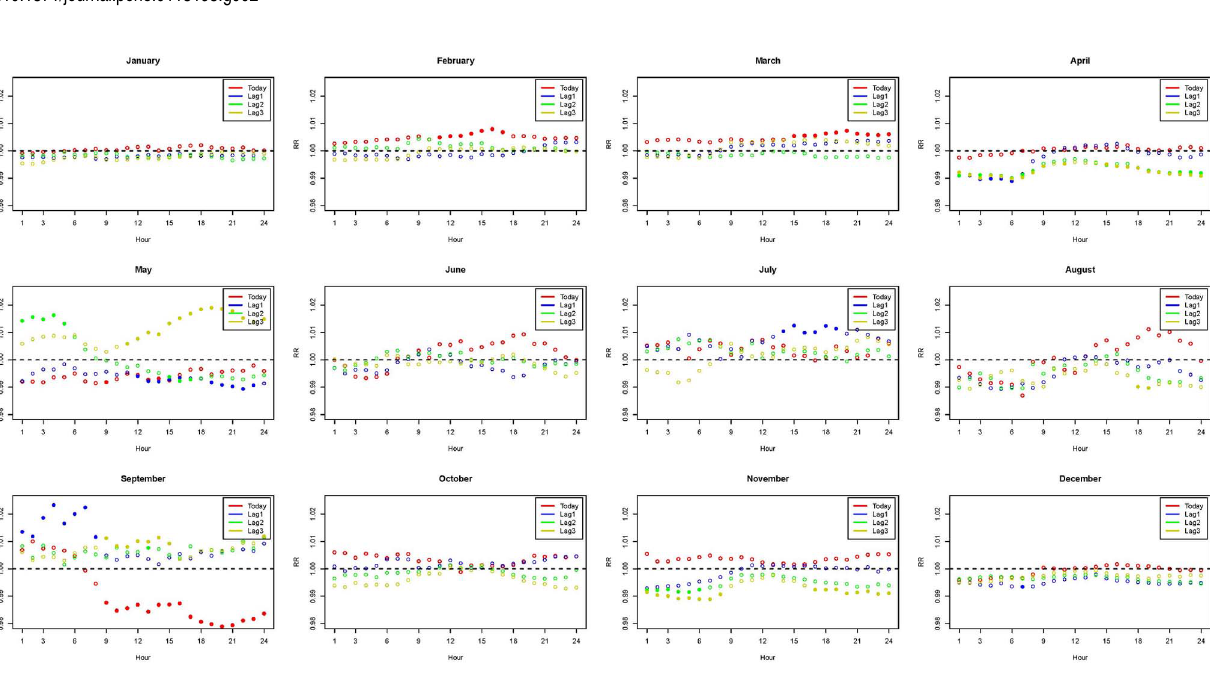
Figure 3. Distribution of hourly relative risk in the younger population adjusted for O 3 . (Abbreviations: max, maximum; min, minimum; RR, relative risk; diff, daily range; T 5am , temperature at 5 am; T 8am , temperature at 8 am.) Models were adjusted for daily mean of ozone exposure, city effects, calendar year, daily relative humidity, and